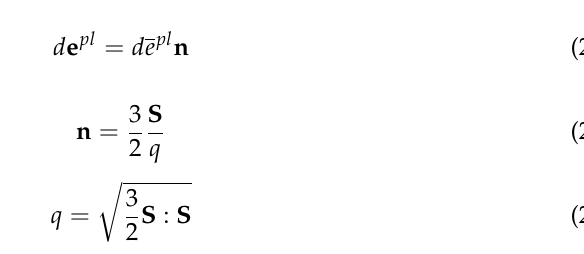
Table 1. Constitutive parameters of simulated material.